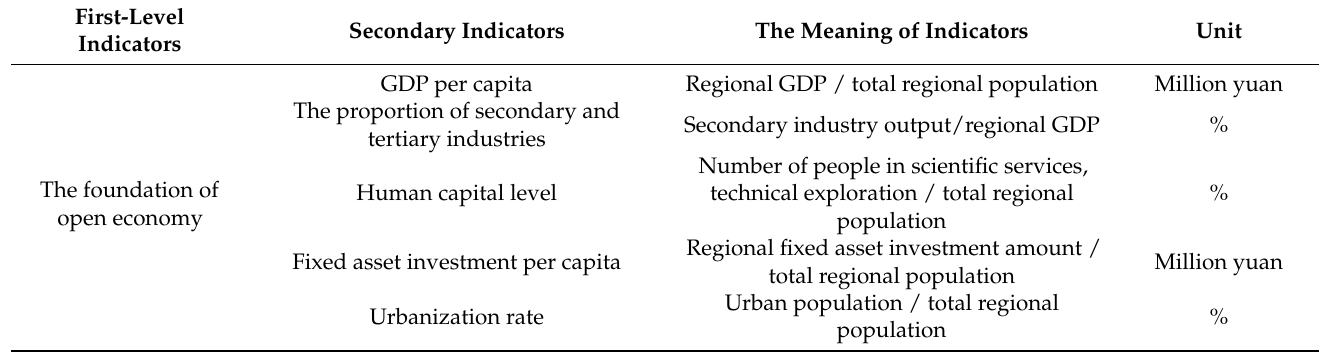
Table 2. Comprehensive evaluation index system of development level of open economy in